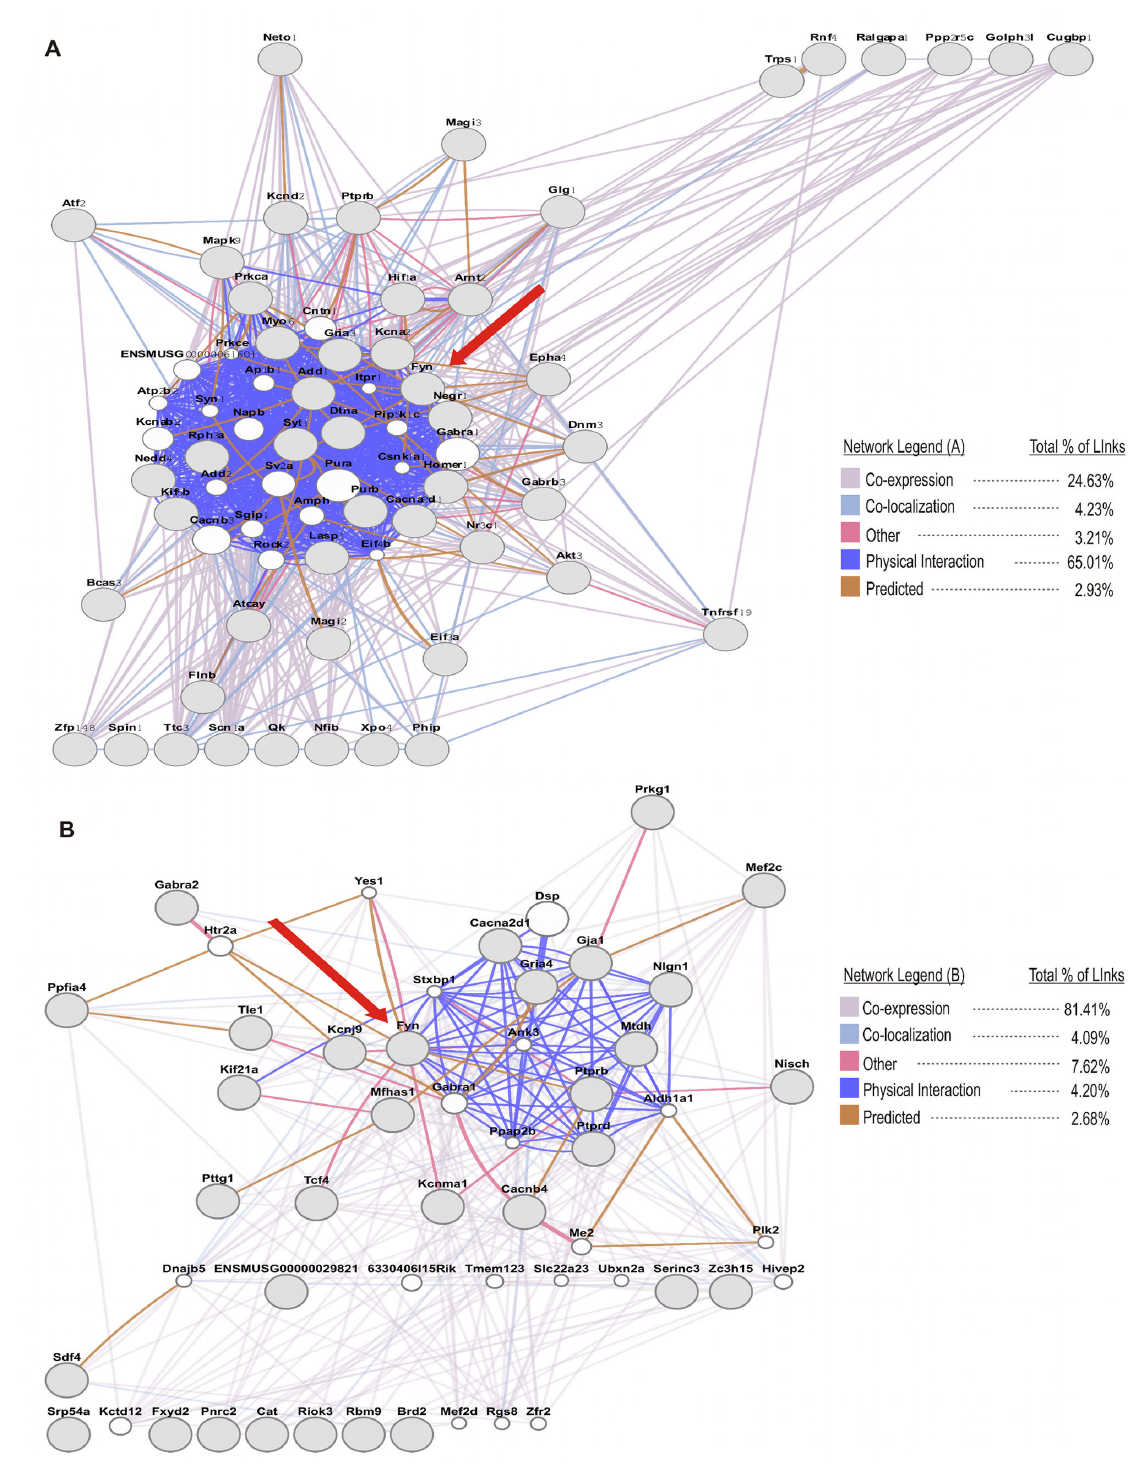
Figure 6. Independent assessment of Fyn kinase correlation networks. GeneMANIA web-tool (http://genemania.org/) analysis using public resources for Fyn-related gene expression networks: (A) Reconstruction of basal network from Figure 4B. (C) Reconstruction of ethanol-responsive network from Figure 4C. Grey nodes are query genes and white nodes are genes predicted form the GeneMANIA algorithm. Red arrow indicates the location of Fyn kinase. doi: 10.1371/journal.pone.0082435.g006 PLOS ONE |